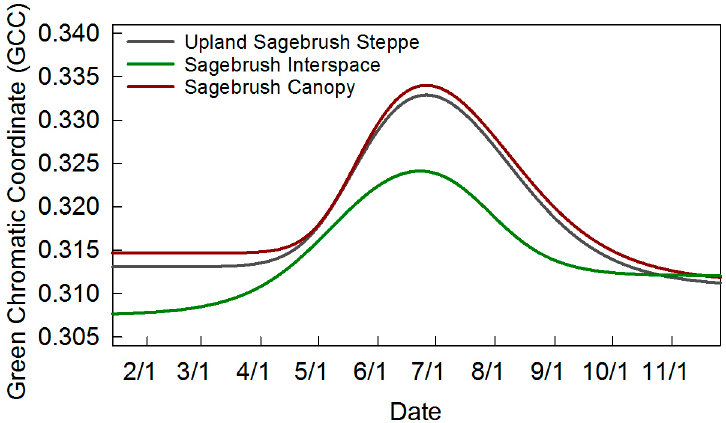
Figure 7. Fitted curves for 3 regions of interest (ROIs): sagebrush steppe community, sagebrush canopy, and interspace. ROIs are shown in Figure 1b.